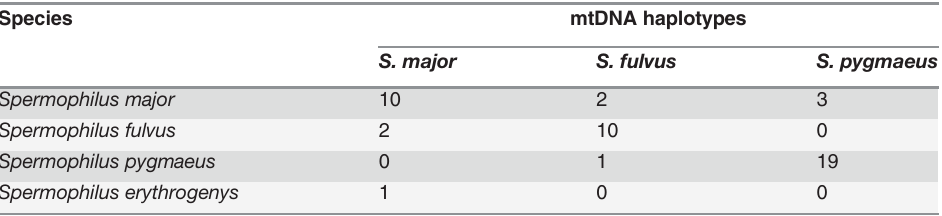
Table 2. Frequency of the introgressed mtDNA haplotypes in four ground squirrel species as revealed by DNA